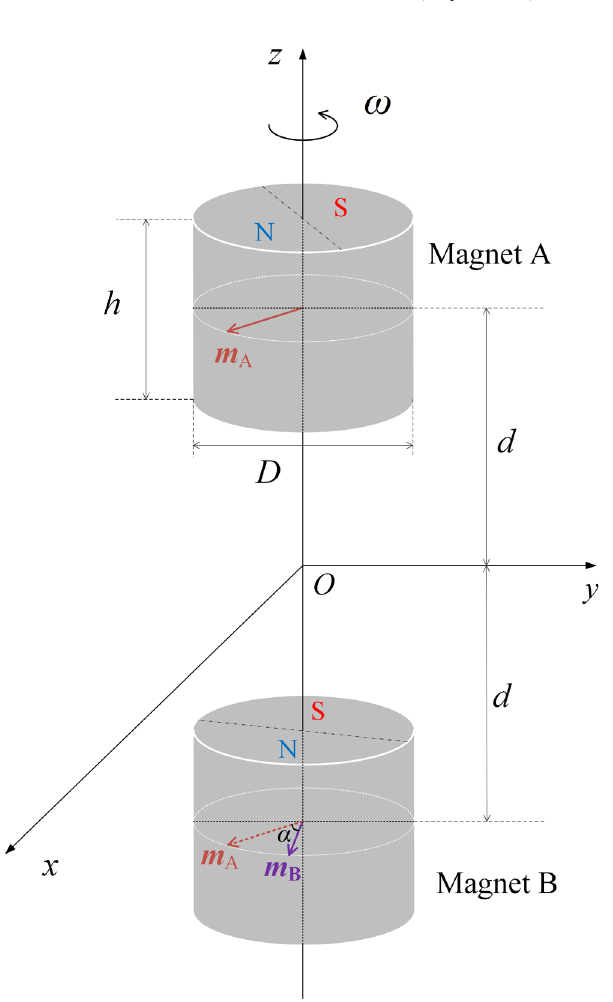
Figure 2. Dual-permanent-magnet mechanical antenna model. In particular, when r >> max( D , h , d ), the impact of d is ignored and d ≈ 0;